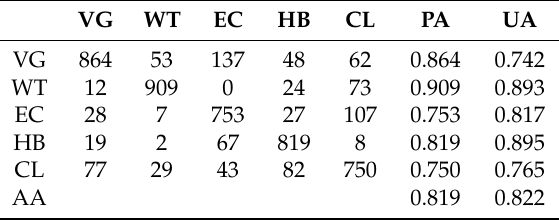
Table 11. Confusion matrix of the CL-DT in the second area.